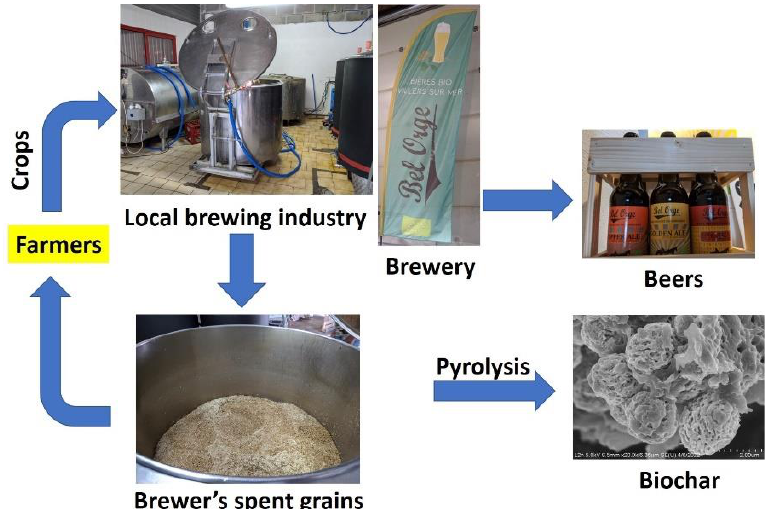
Figure 1. Pictorial representation of the brewing industry, generation of BSGs and their valoriza-